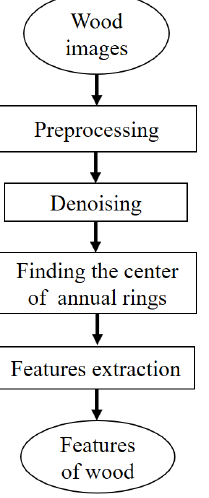
Figure 1. The process of features extraction of wood.